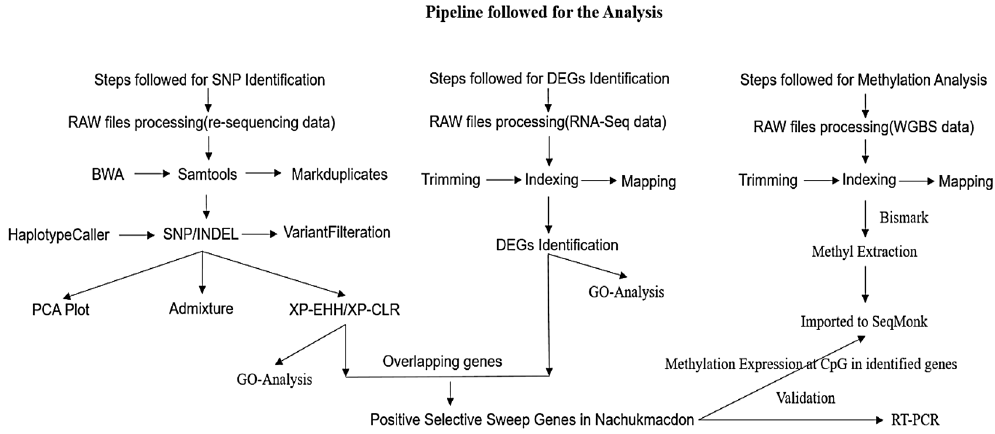
Figure 5. Overview of the pipeline followed to identify selective sweep